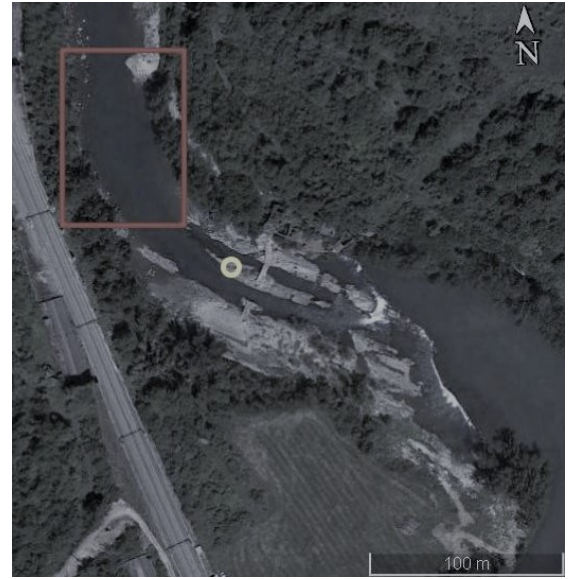
Figure 2. Study area: Arno river in the locality of Prulli